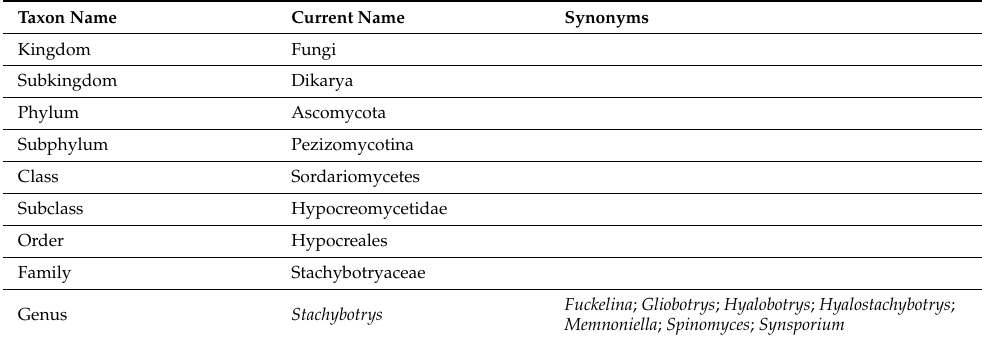
Table 1. Current taxonomic position of Stachybotrys chartarum (Ehrenb.) S. Hughes (1958) and related species 1 − 4